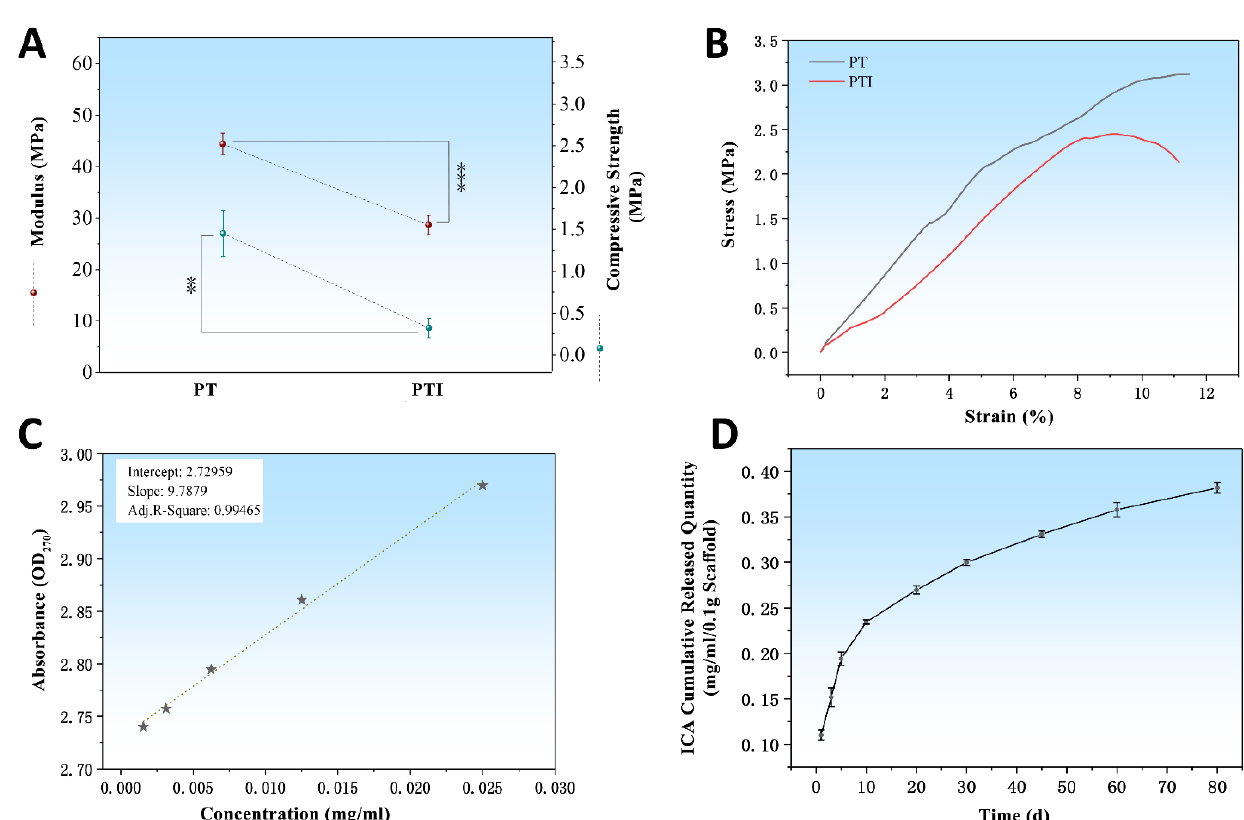
Figure 3. Mechanical properties of scaffolds and the release of ICA. ( A ) Mechanical properties of two groups of scaffolds including elastic modulus and compressive strength, ( B ) stress – strain curve showing the change trend of two groups of scaffolds after being stressed, ( C ) standard curve for ICA, and ( D ) the ICA release behaviour of PTI scaffold within 80 days. * p ≤ 0.05, ** p ≤ 0.01, *** p ≤ 0.001.